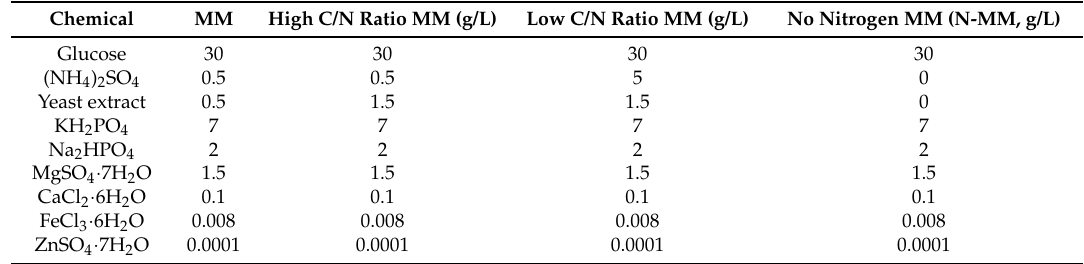
Table 1. Minimal medium (MM) recipe used for nitrogen depletion experiments presented in Figure